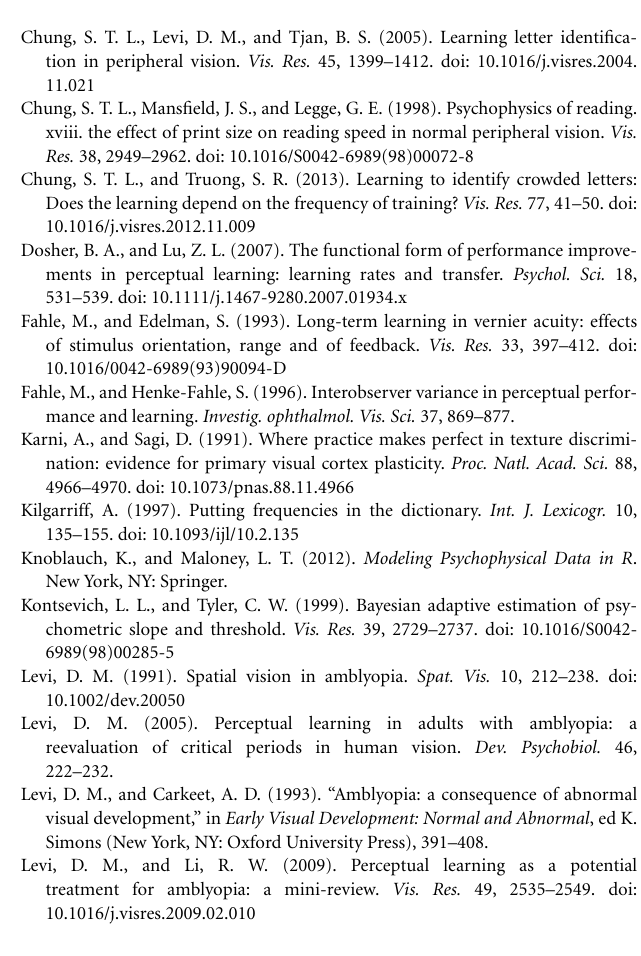
FIGURE 7 | Schematic improvement in performance (duration) at all points on the psychometric functions shown in Figure 6. At a given performance level (proportion correct), the corresponding stimulus durations